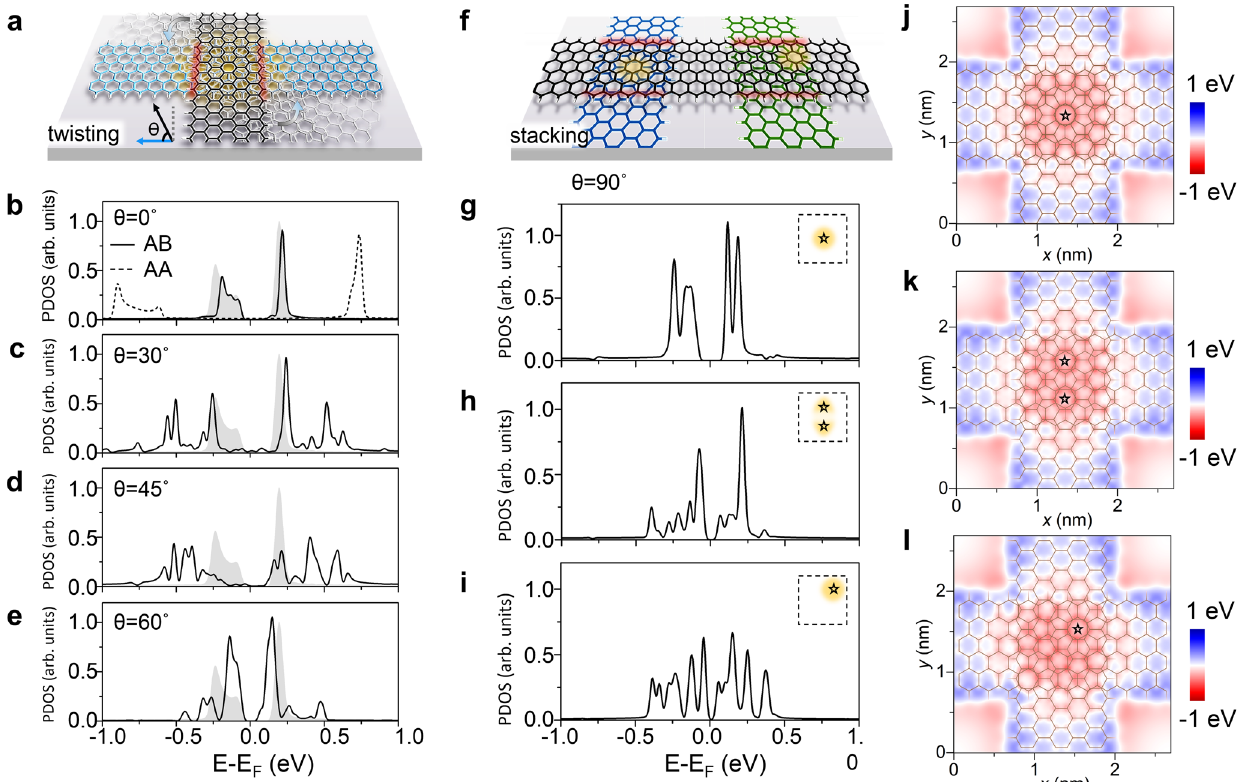
Fig.1|Tunabilityofzigzaggraphenenanoribbon(ZGNR)edgestateswithtwist angles and in-plane stacking offsets. a Schematic of twisted bilayer zigzag gra- phene nanoribbon (TBZGNR) junctions with varying twist angles. Blue and black ribbonsrepresentbottomandtoplayerZGNRs,respectively(alsoin f ).Theangle θ represents the twist angle between the top and the bottom ribbon. Red shadow regions illustrate the edges of the top layer ZGNR within the overlapping region (also in f ). b – e Density-functional-theory (DFT)-calculated projected density of states (PDOS) on the edge atoms in the red shadow regions in cases with several typicaltwistangles.Inthecaseofatwistangleof0°,both β -AB(solidcurve)andAA stacking (dashed curve) are considered. The grey shading represents the PDOS for edge atoms in monolayer ZGNR. The results in c – e are based on structures with